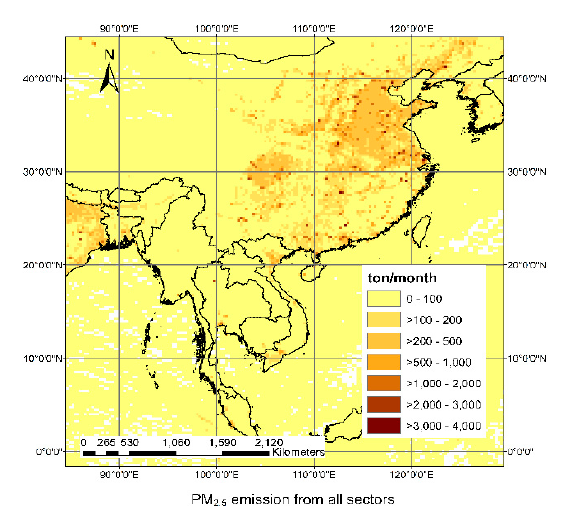
Figure 5. Spatial distribution of primary PM 2.5 in December 2010 from all sectors in d01.